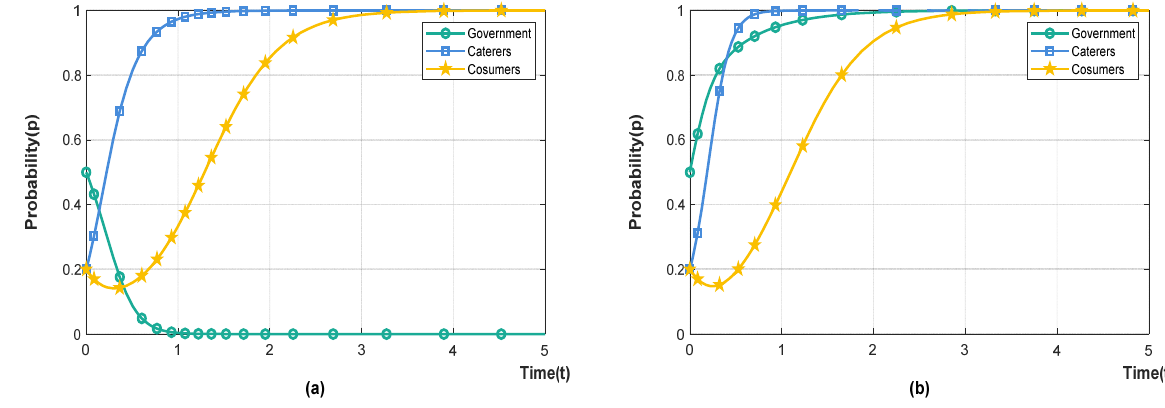
Figure 1. System evolution steady state. ( a ) E g 1 < E g 2 . ( b ) E g 1 > E g 2